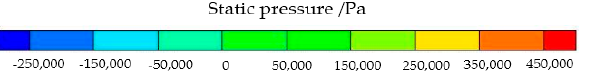
Figure 12. Variation of static pressure in different impellers.